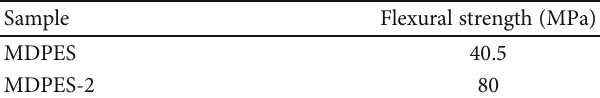
Table 3: Bending strength of MDPES resin